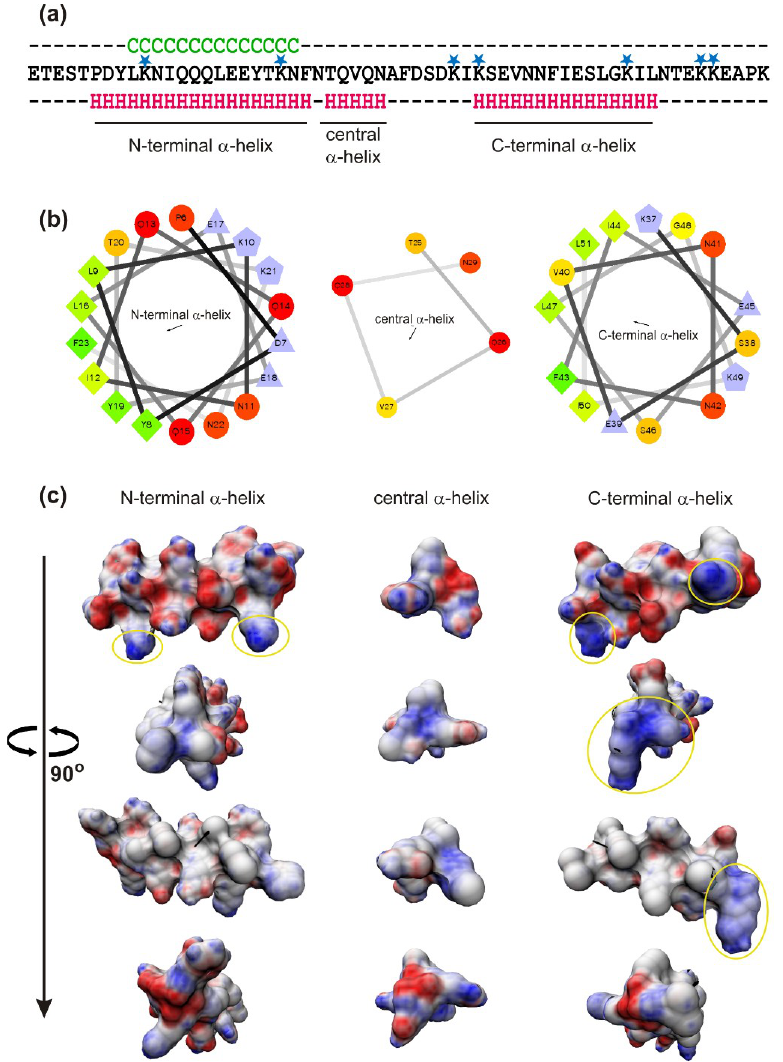
Figure 8. Prediction of α-helices and regions prone to aggregation ( a ), helical wheel projections presenting distribution of hydrophobic and hydrophilic amino acid residues ( b ), and distribution of electrostatic potential on the surface ( c ) of the α-helices predicted in G. mellonella anionic peptide 2. (a): the Jpred4 protein secondary structure prediction server available at http://www.compbio.dundee.ac.uk/jpred/ was used for prediction of α-helices (bottom line) and aggregation regions (upper line). Residues forming putative α-helices and involved in aggregation are marked H (pink letters) and C (green letters), respectively. Potentially exposed lysine residues (K) are indicated above the AP2 sequence by blue asterisks. (b): the hydrophilic, hydrophobic, potentially negatively charged, and potentially positively charged residues are represented by circles, diamonds, triangles, and pentagons, respectively. Hydrophilic uncharged and potentially charged residues are coded, respectively, red and light blue. Hydrophobic residues are coded yellow (zero hydrophobicity) to green (the most hydrophobic). The arrows inside the helical wheel projections indicate hydrophobic vectors (http://rzlab.ucr.edu/scripts/wheel/wheel.cgi). (c): the predicted N-terminal (left column), central (middle column), and C-terminal (right column) α-helices are presented as four pictures that represent rotations of 90 degrees around the z-axis (vertical). Positively and negatively charged areas are colored blue and red, respectively. The yellow ellipses encircle the most exposed positively charged regions. Non-polar regions are in gray. The electrostatic potential was analyzed using 3D-HM: The 3D Hydrophobic Moment Vector Calculator available as a web application on http://www.ibg.kit.edu/HM/.